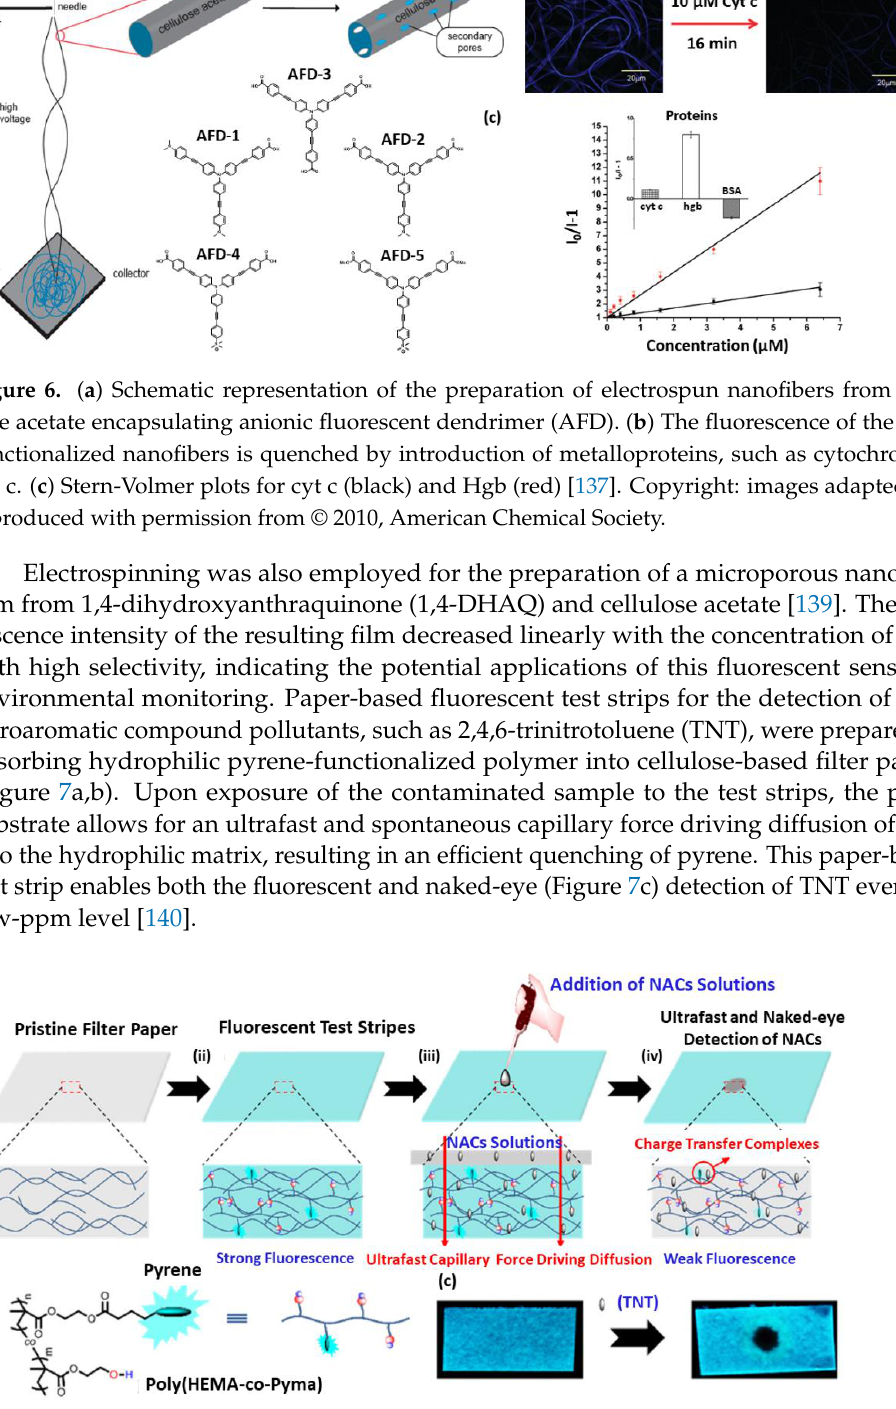
Figure 7. ( a ) Schematic representation of the preparation of a paper-based fluorescent test strip by absorbing hydrophilic pyrene-functionalized polymer into cellulose-based filter papers (i), followed by drying it (ii). The resulting fluorescent paper sensor was used for the detection of nitroaromatic compound (NAC) pollutants, consisting in the NAC-induced quenching of pyrene excimer emission (iii,iv). ( b ) Structures of the pyrene-functionalized polymer poly (HEMA-co-PyMA). ( c ) Fluorescence response (under UV lamp at 365 nm) of the paper-based sensor for detection of 25 ppm TNT sample in aqueous solution [140]. Copyright: images adapted and reproduced with permission from © 2017, American Chemical Society.